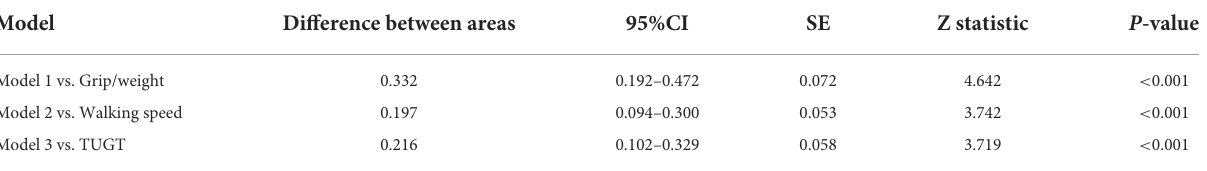
Model1:Grip/weight,plusmetabolitepanel. Model2:Walkingspeed,plusmetabolitepanel.